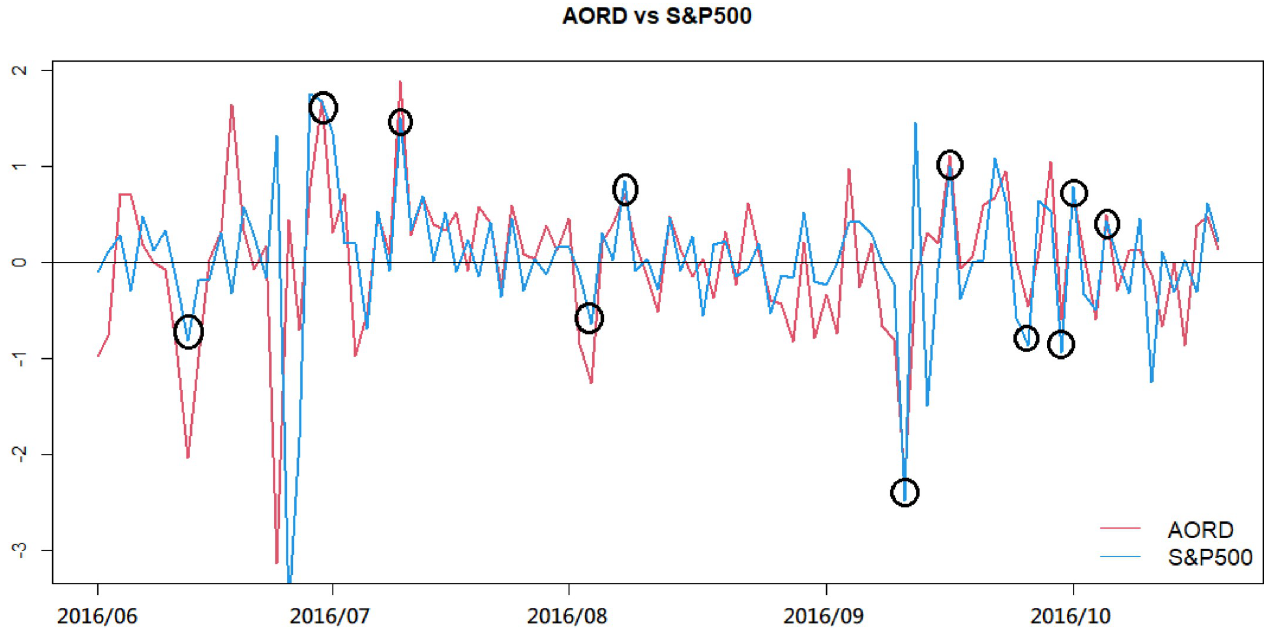
Fig 1. Log returns of the AORD and S&P500 indices from Jun. to Oct. in 2016.